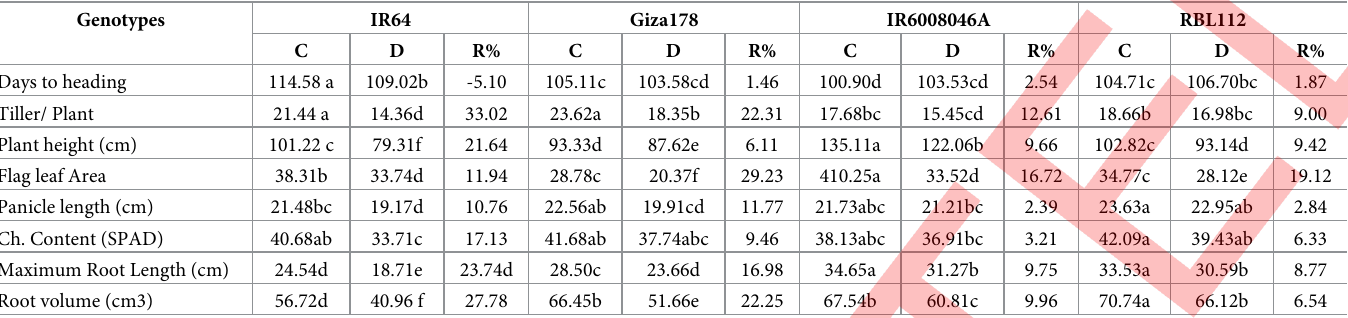
Table 2. Mean performance of the studied genotypes for growth traits in both environments and their combined data during the two growing seasons. Genotypes